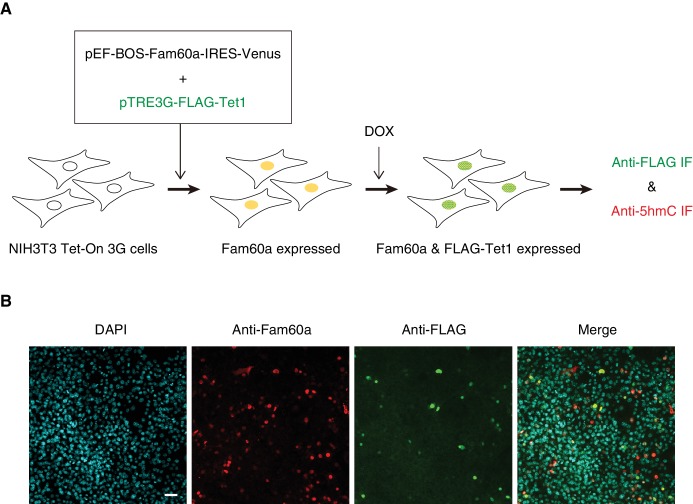
Experimental strategy for expression of Fam60a and Venus and inducible expression of FLAG-Tet1 in NIH3T3 cells.(A) Schematic representation of cell transfection and induction of FLAG-Tet1 expression by doxycycline (DOX) for the experiments shown in Figure 6C–F. (B) Immunofluorescence (IF) staining of cells transfected and induced to express FLAG-Tet1 as in A). Staining was performed with antibodies to Fam60a and to FLAG at 24 hr after doxycycline administration. Nuclei were stained with DAPI. Scale bar, 50 µm.